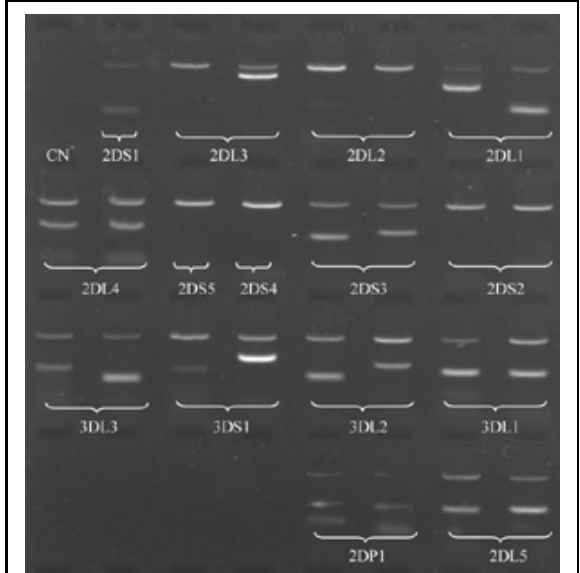
Figura 5 – PCR desenvolvida com a enzima Taq DNA polimerase recombinante da Invitrogen ® . A concentração de MgCl a 1,5 mM (a) e 2 mM 2